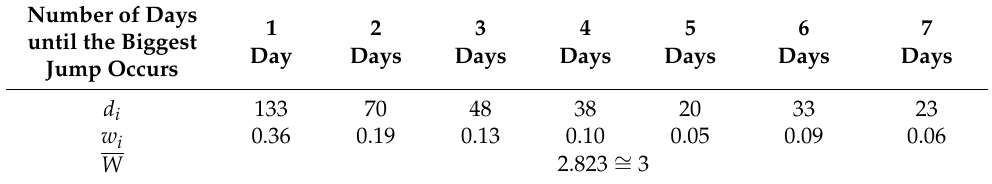
Table 3. Example of computing one-year weighted average of the largest jump in seven days.